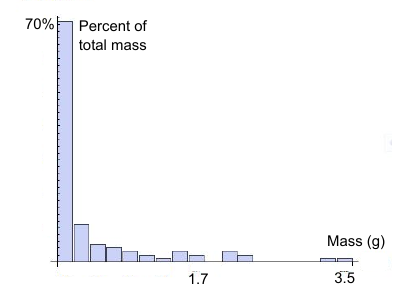
Figure A2. The mass distribution for the 5.2 m Douglas fir firebrands plotted as histogram from the data from [5]. The histograms for the other taller specimens for each species studied are similar. Along the x -axis we plot firebrand mass in